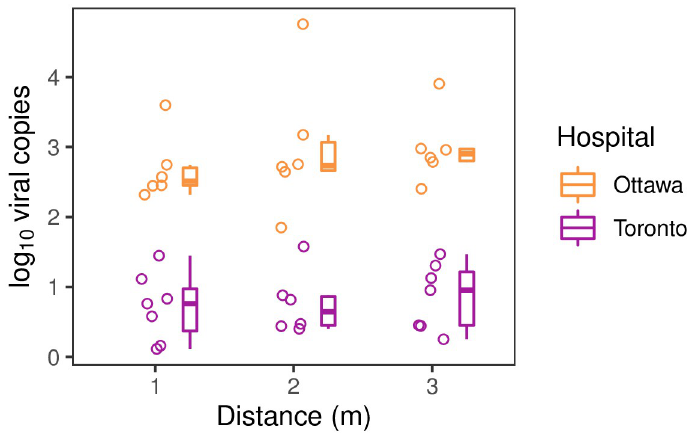
Fig 3. A comparison of detected SARS-COV-2 at varying distances across COVID-19 patient rooms at two hospitals. m = metre. Distance was measured from the patient’s bed, with 3 m indicating where the room connected with the hallway (typically 3 m to 5 m from the patient’s bed). Points show the patient room means of log 10 viral copies from all the positive swabs collected (negative results were excluded from the calculation of room-level means). Boxplots summarize these values for each